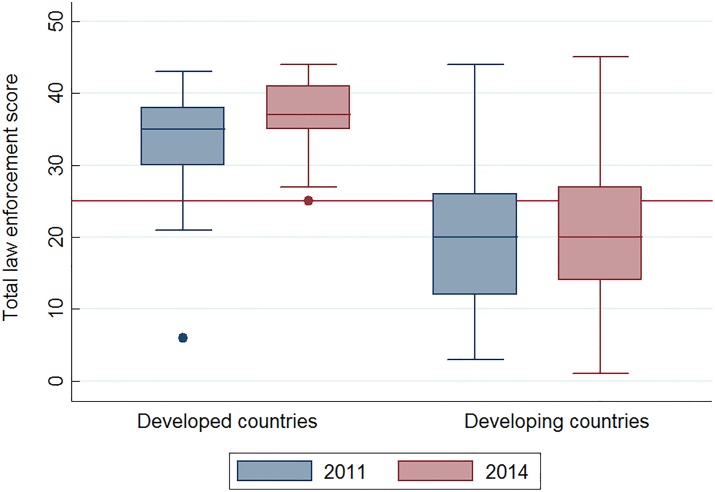
Total enforcement score of five kinds of national road traffic laws in 2011 and 2014 by development status.Notes: 1. National law enforcement scores in 2011 and in 2014 were from the Global Status Report on Road Safety 20134 and 20155, respectively. Total enforcement scores of five kinds of national road traffic laws were calculated, including speed limit law, drink-driving law, motorcycle helmet law, seat-belt law, and child restraint law. Total enforcement score ranged from 0 to 50; 0 points indicated the weakest legislation effort and 50 points mean the strongest legislation effort. 2. Differences in total law enforcement scores was statistically significant between developed countries and developing countries in 2011 (Z = 7.21, P<0.05) and in 2014 (Z = 8.09, P<0.05). 3. Change in total law enforcement score between 2011 and 2014 was not significant for developing countries (Z = -0.90, P>0.05) but was significant for developed countries (Z = -2.10, P<0.05).